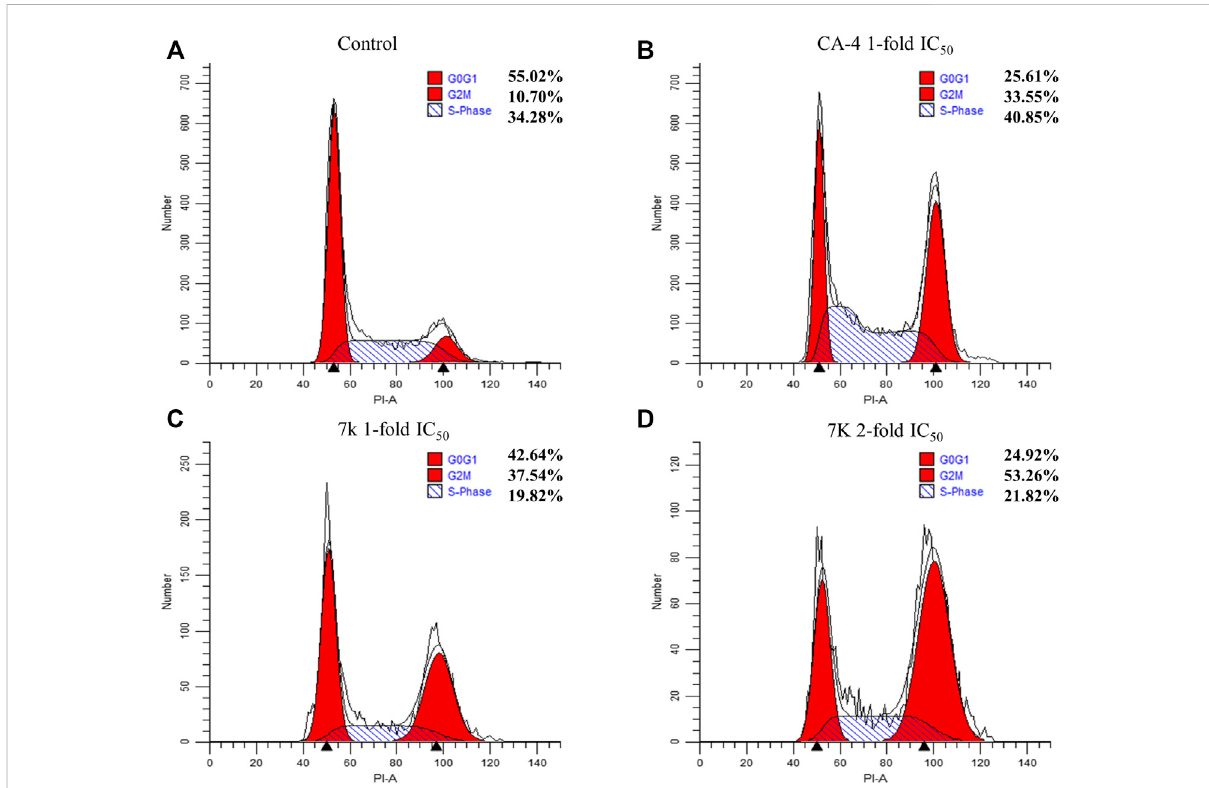
FIGURE 5 Effect of 7k and CA-4 on HeLa cell cycle progress. Flow cytometry analysis of HeLa stained by propidium iodide and treated with different concentrations of 7k for 24 h. (A) Control; (B) CA-4, 1-fold IC 50 ; (C) 7k , 1-fold IC 50 ; (D) 7k , 2-fold IC 50 .